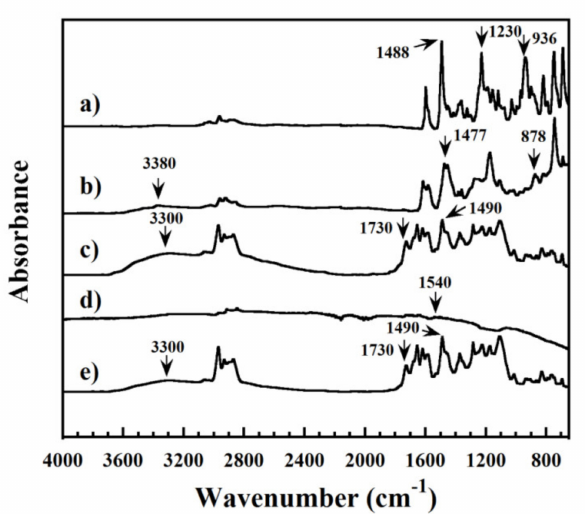
Figure 3. FT-IR spectra recorded for the ( a ) BA-a monomer, ( b ) poly(BA-a), ( c ) poly(BA-a/PU), ( d ) neat MWCNTs, and ( e ) poly(BA-a/PU) composite containing